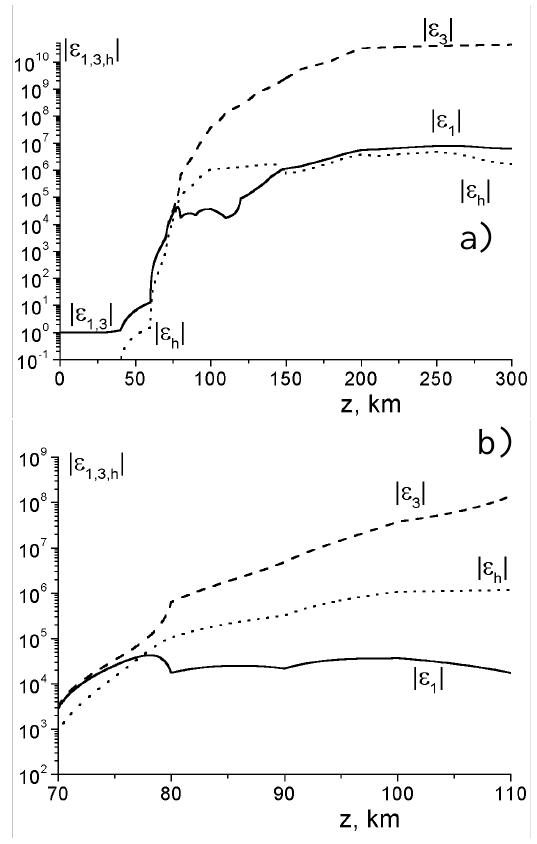
Fig. 3. Vertical dependencies of the absolute values of components of complex tensor of dielectric permittivity of atmosphere and iono- sphere at ω =50s − 1 used in the simulations (daytime, normal solar activity) (a) . The detailed dependence for the heights 70 ÷ 110km (b) .